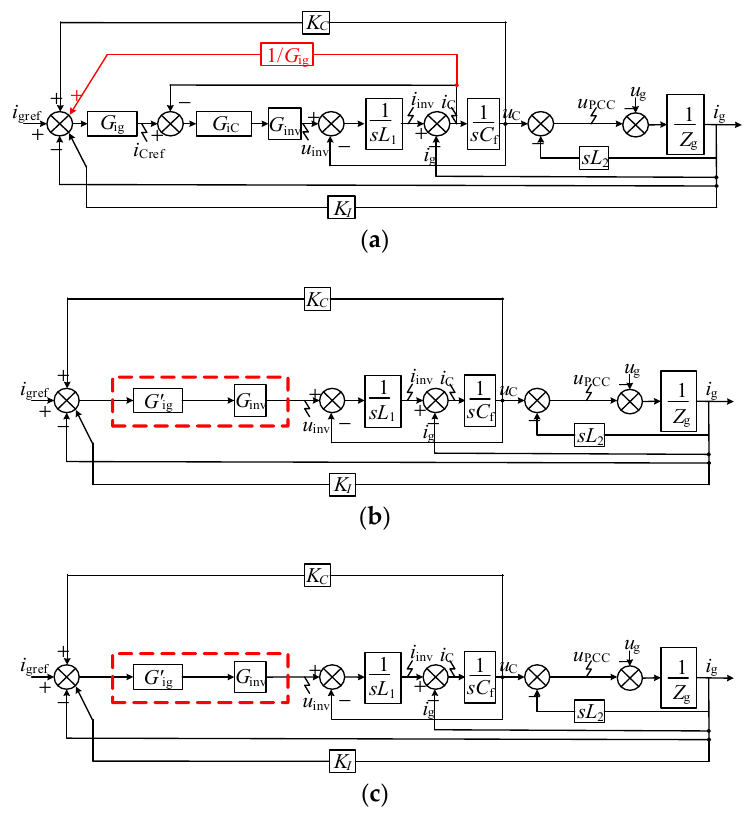
Figure 12. Proposed control loop of capacitor voltage and grid current feedback. ( a ) Optimization step I; ( b ) optimization step II; ( c ) proposed control structure, respectively.